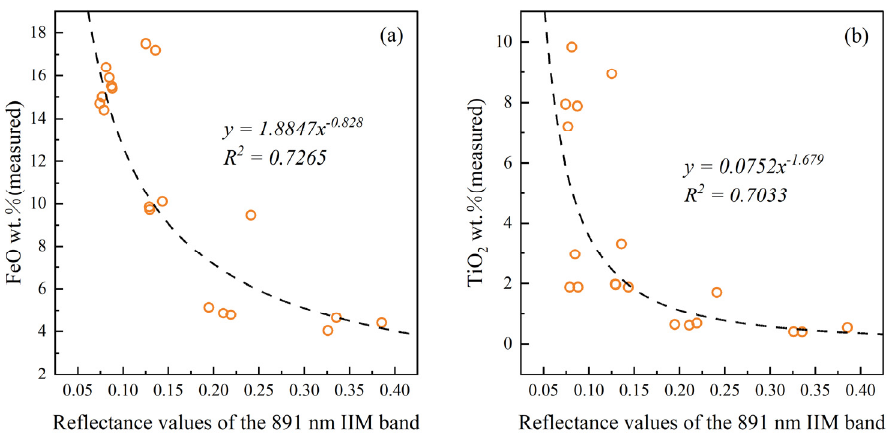
Figure 4. Relationship between the 891 nm reflectance and the ( a ) FeO and ( b ) TiO 2 contents in LSCC samples with 10–20 μ m grain sizes.